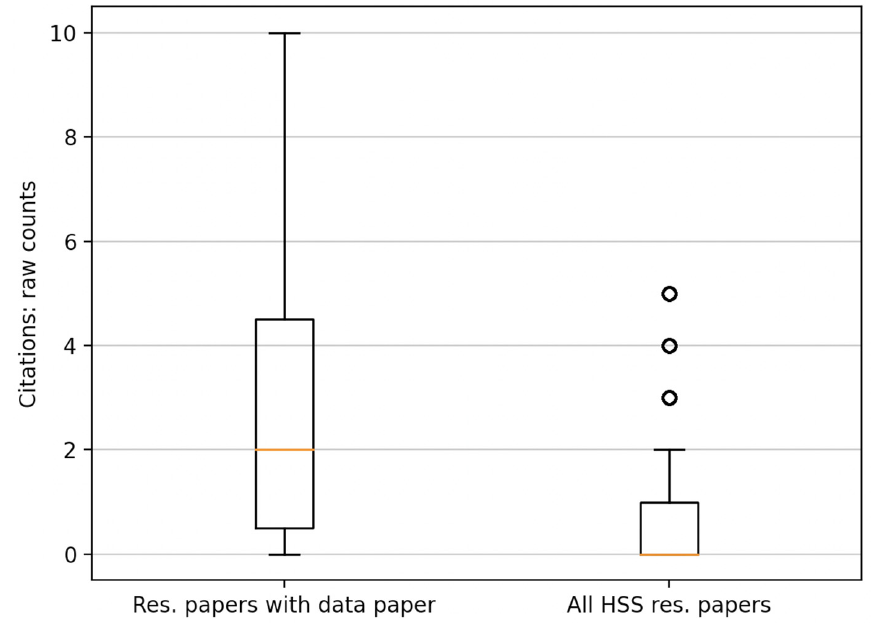
Figure 11. Comparison between research papers with an associated data paper and all HSS research papers (2015–2022): citation counts. Table 6. Welch’s t -test and Mann–Whitney U -test results: mean citations of research papers with an associated data paper and all HSS research papers between 2015 and 2022, at each random sampling of the latter.